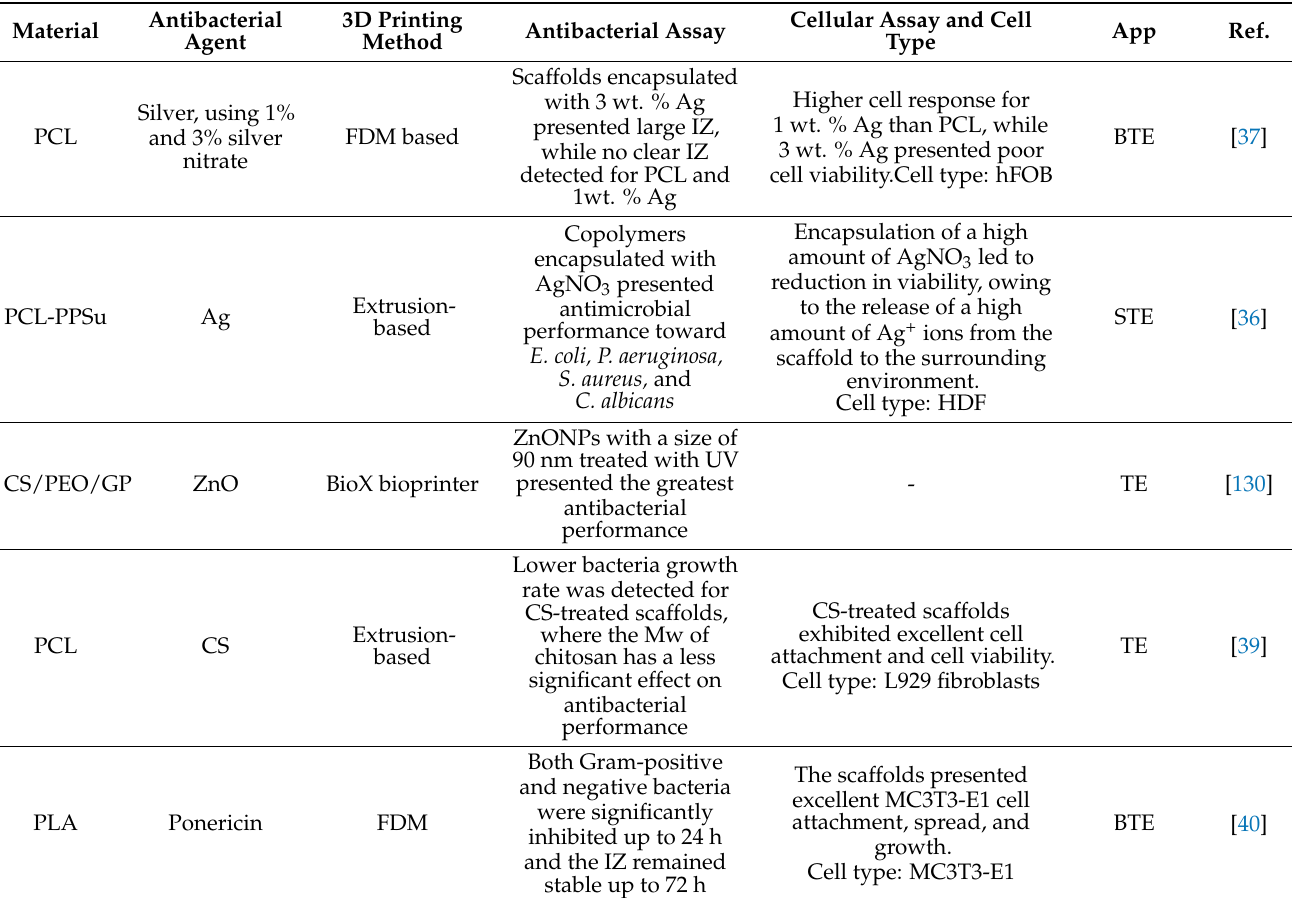
Table 2. Printing inks containing antibacterial